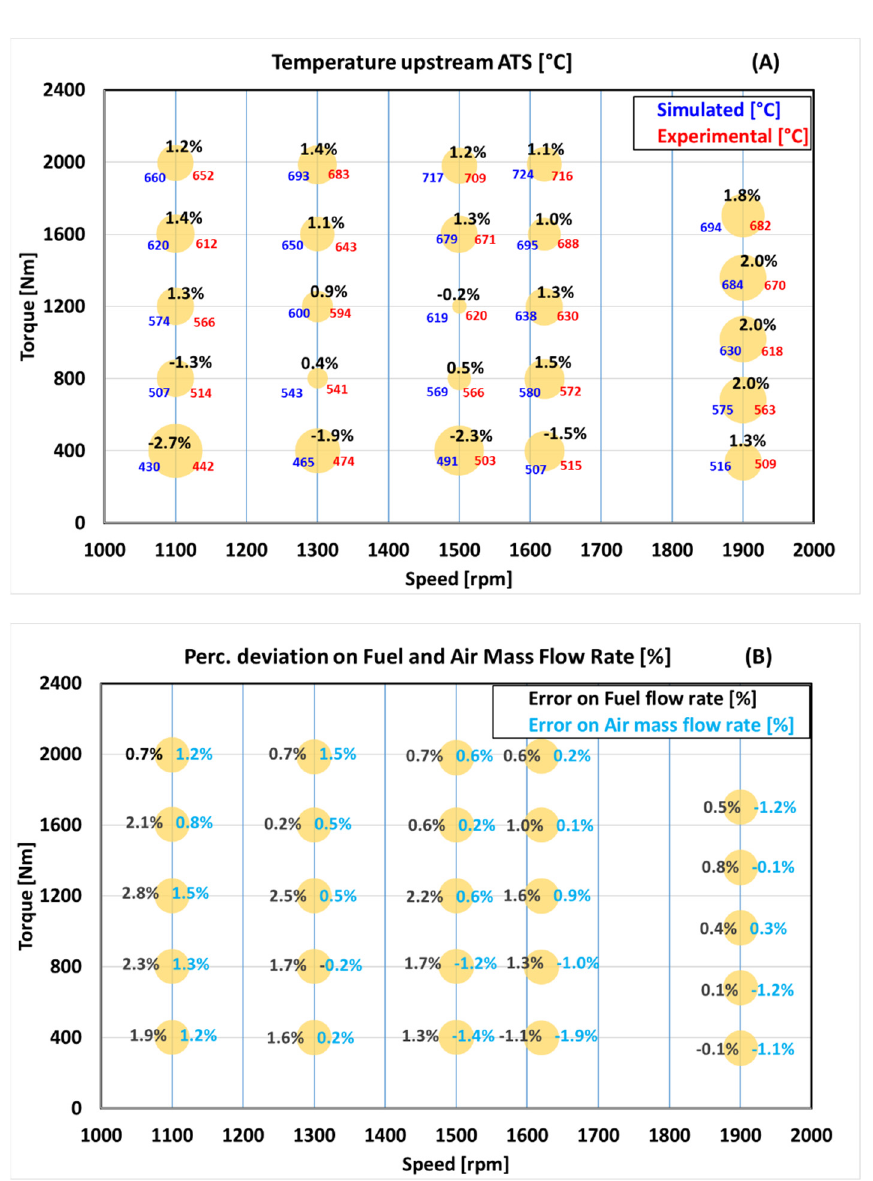
Figure 8. Percentage deviation between simulated and experimental data before ATS temperature ( A ); fuel and air mass flow rate ( B ) in the 25 tested operating conditions.